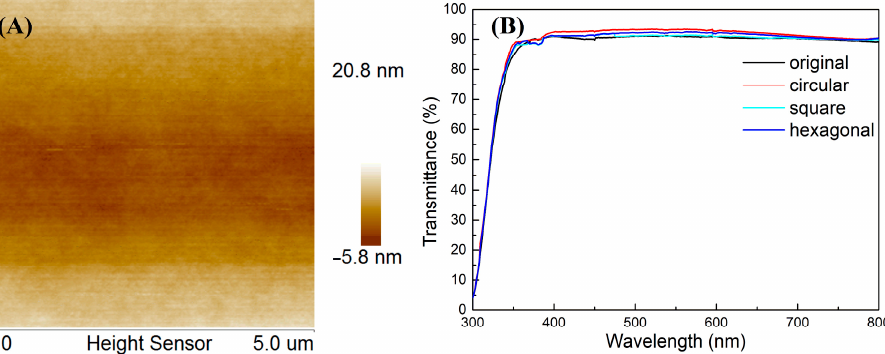
Figure 3. ( A ) AFM image of the organic–inorganic hybrid film baked at 100 °C for 10 min, and ( B ) light transmission properties of the organic–inorganic hybrid film MLAs.